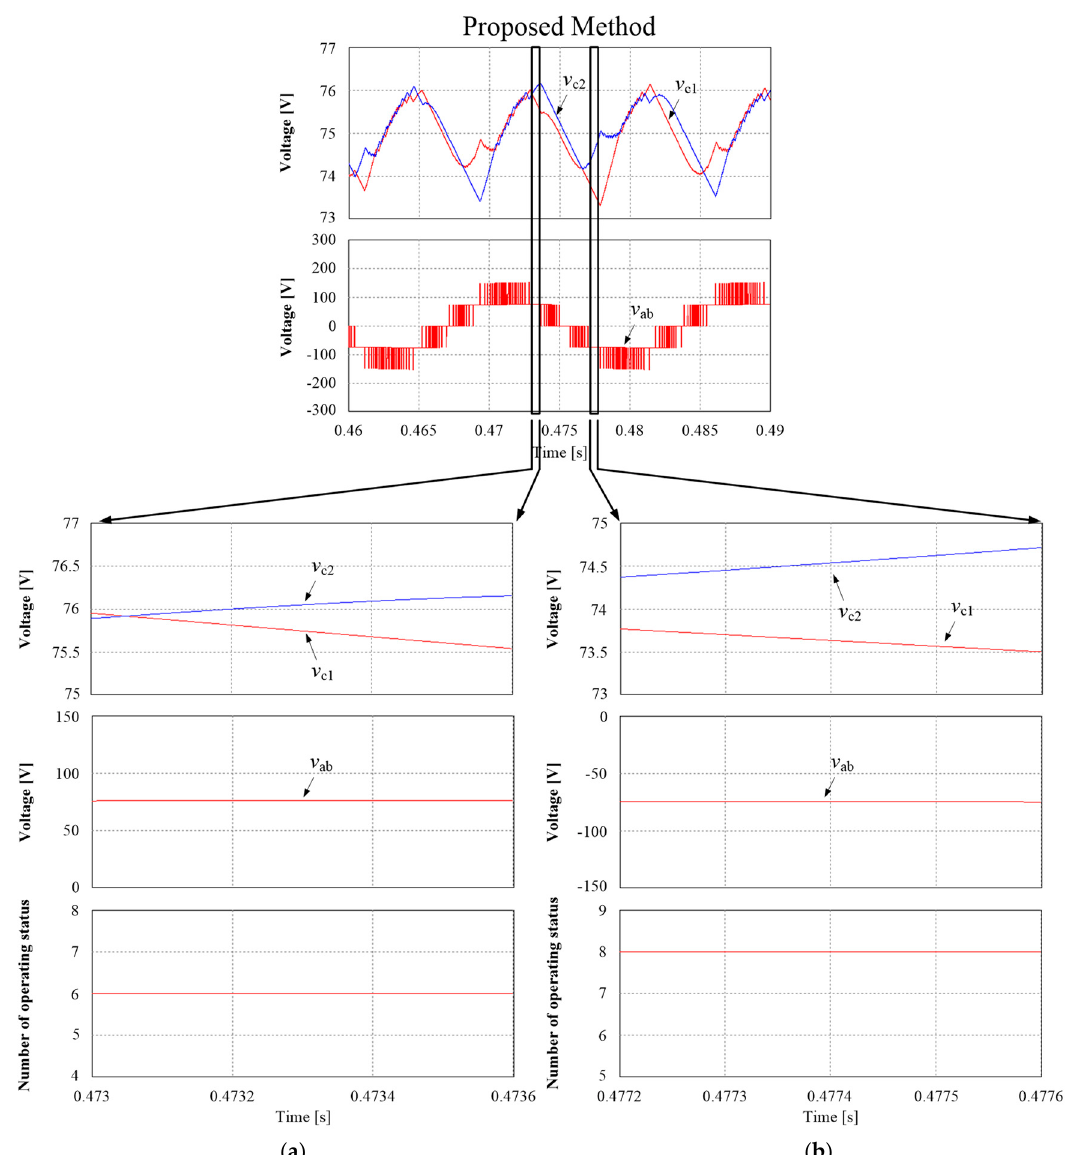
Figure 3. Simulation waveforms of proposed MPC method ( a ) during period with converter voltage v ab fixed to V dc /2 and ( b ) during period with converter input voltage v ab fixed to − V dc /2.